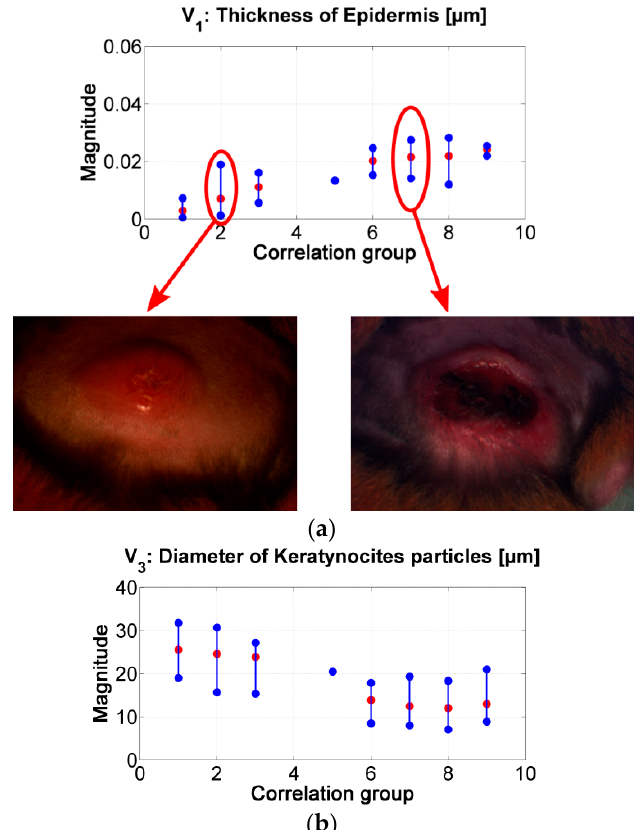
Figure 8. ( a ) results of the inverse-modeling procedure for variable V 1 : thickness of epidermis. ( b ) results of the inverse-modeling procedure for variable V 3 : diameter of keratynocite particles.